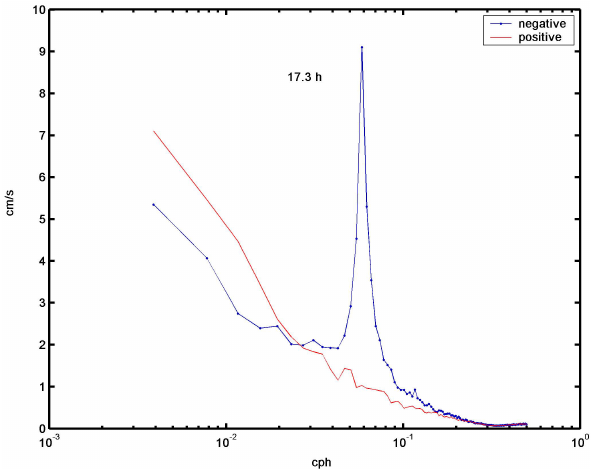
Fig. 12. Vertically averaged rotary spectrum of hourly mean cur-